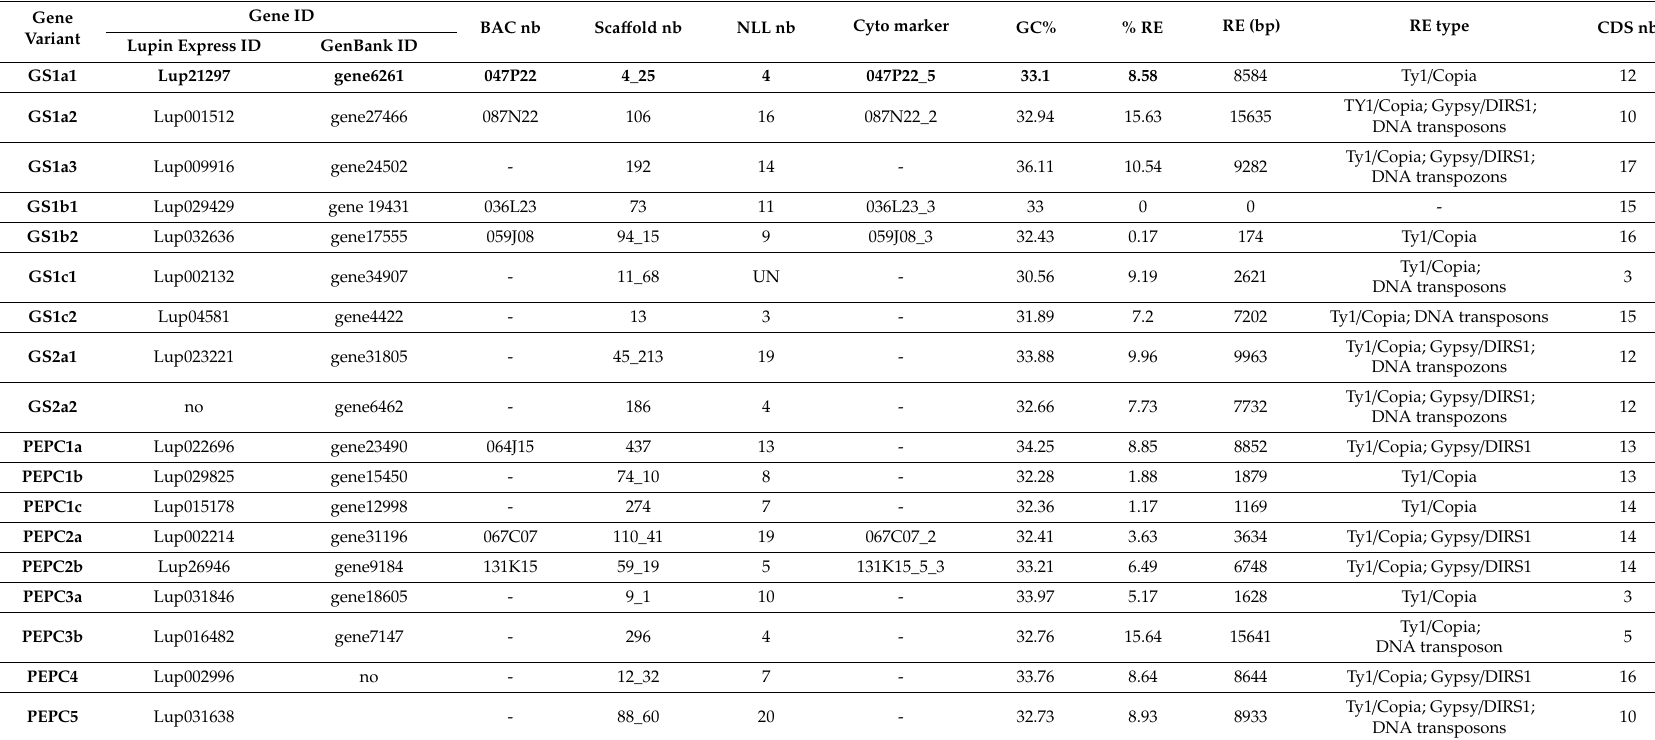
Table 1. Characterization of Lupinus angustifiolius bacterial artificial chromosomes (BACs) / sca ff olds carrying glutamine synthetase ( GS ) and phosphoenolpyruvate carboxylase ( PEPC ) sequences, including anchoring genes to the sca ff olds and narrow-leafed lupin linkage groups (NLLs), cytogenetic marker representation, and repetitive content analysis within selected sca ff olds. NLL—narrow-leafed lupin linkage group, RE—repetitive element, and CDS—coding sequence. Gene